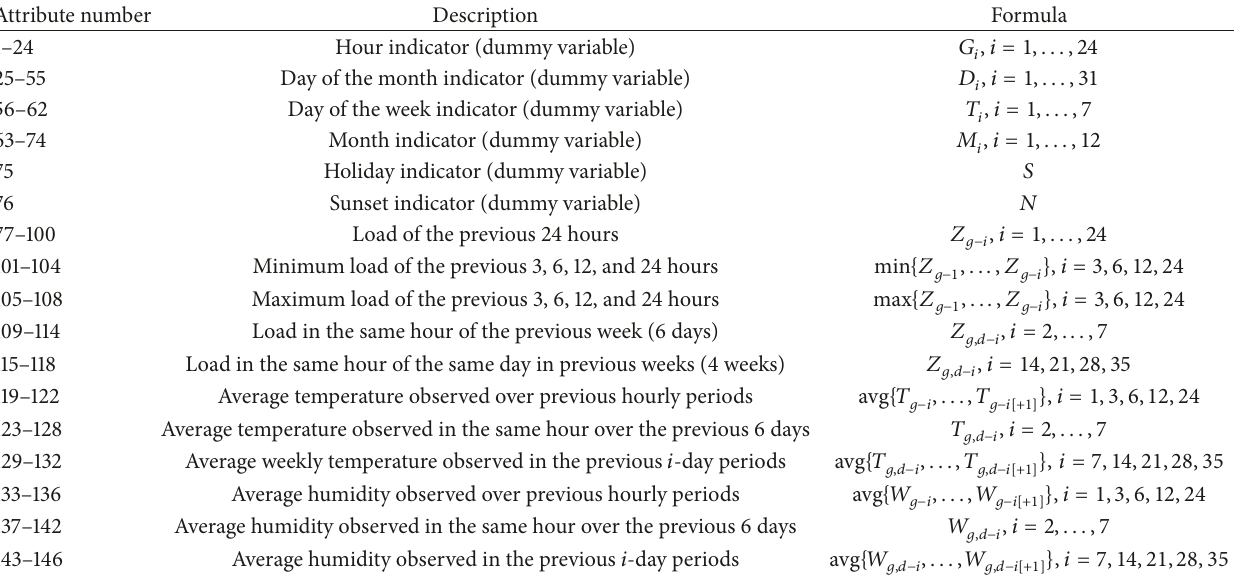
Table 5: Feature vector used in